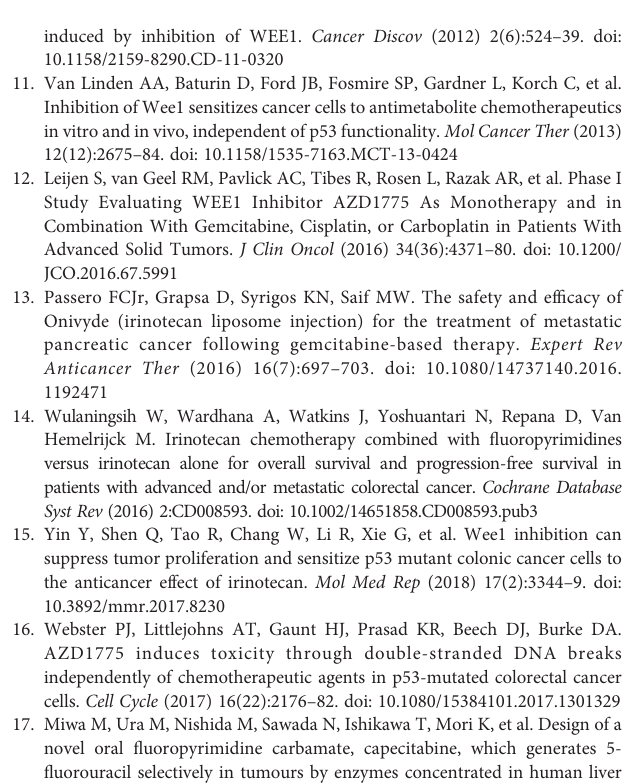
Supplementary Figure 1 | Anti-proliferative effects of AZD1775 (125 nM) and (A) SN38 or (B) 5-FU in PDAC cell lines. PDAC cells were treated with AZD1775 and SN38 or 5-FU, and proliferation was measured over a 72 hour period using the IncuCyte Zoom with data normalized to hour 0. Data were analyzed with a t-test to compare single agents to the combination (* = p ≤ 0.05, ** = p ≤ 0.01, *** = p ≤ 0.001, **** = p ≤ 0.0001). Statistical signi fi cance between the single agent and combination is indicated next to the single agent. Supplementary Figure 2 | Apoptotic effects of AZD1775 (125 nM) and (A) SN38 or (B) 5-FU in PDAC cell lines. Cells were treated with AZD1775 and SN38 or 5-FU for 24 and 48 hours, and apoptosis was measured using a Caspase Glo 3/7 assay with data normalized to the No Drug control. Data were analyzed with a t-test to compare single agents to the combination (* = p ≤ 0.05, ** = p ≤ 0.01, *** = p ≤ 0.001). Supplementary Figure 3 | Cell cycle analysis of AZD1775 (125 nM) and (A) SN38 or (B) 5-FU in PDAC cell lines. Cells were treated with AZD1775 and SN38 or 5-FU for 24 and 48 hours, then cell cycle arrest was assessed using Krishan ’ s stain followed by fl ow cytometry. Data were analyzed with a t-test to compare single agentstothecombination(*= p ≤ 0.05,&= p ≤ 0.01,$= p ≤ 0.001,#= p ≤ 0.0001). Supplementary Table 1 | The synergistic effects of AZD1775 (125 nM, 250 nM) and SN38 or 5-FU in PDAC cell lines. Bliss additivity was calculated using the 72 hour proliferation data averages. Values greater than 1 indicate synergy between the two agents